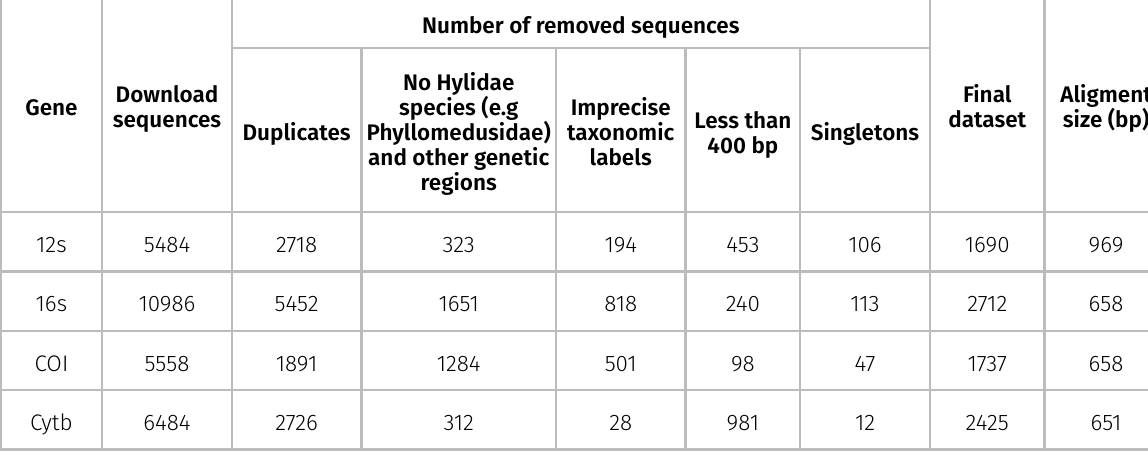
Table I. Curation and alignment size of genetic markers in each dataset.